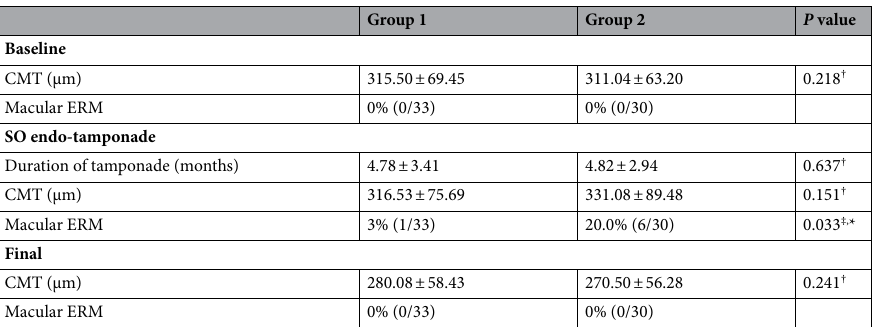
Table 4. Central macular thickness and macular ERM according to timing of ILM peeling. The data are shown as the mean ± standard deviation or as the percentage (number). Group 1, ILM peeling during SO injection surgery. Group 2, ILM peeling during SO removal surgery. † unpaired t -test. ‡ chi-squared test. * P < 0.05, statistically significant. CMT central macular thickness, ERM epiretinal membrane, ILM internal limiting membrane, SO silicone